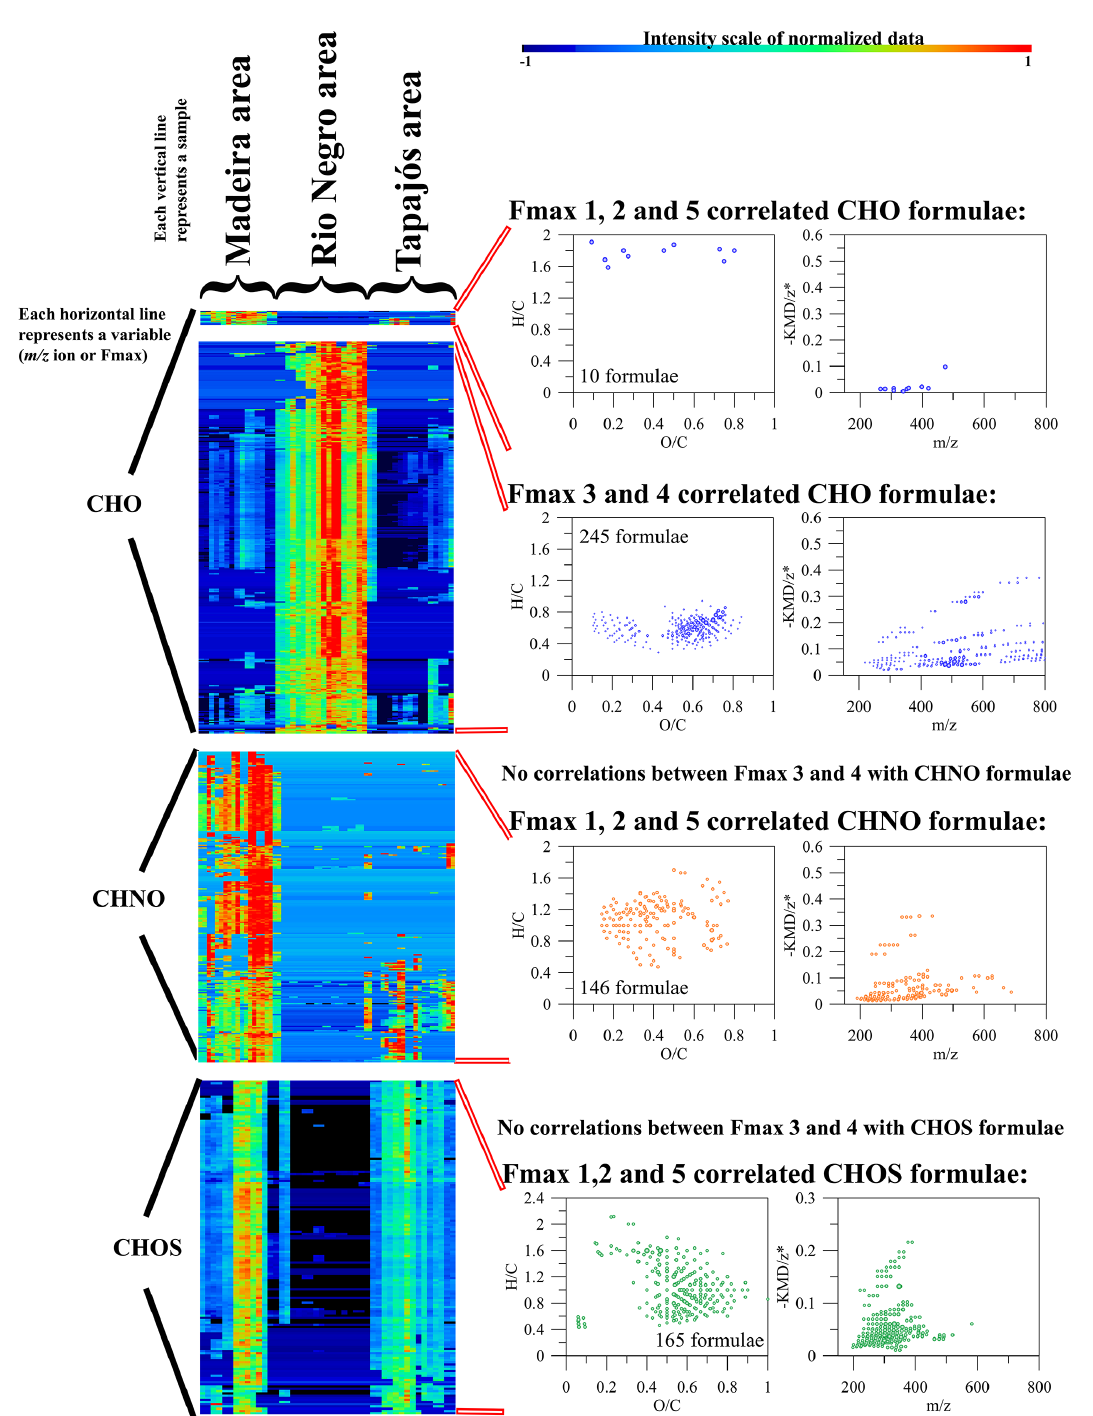
Figure 5. Heat maps of specific Spearman’s rank-correlated hierarchical clusters (distance threshold 0.6) that showed correlations between m/z ions and Fmax values separated into the dissolved organic carbon (CHO) nitrogen (CHNO) and sulfur (CHOS) pool. The van Krevelen diagrams correspond to the molecular signatures that co-varied with specific EEM-PARAFAC Fmax values. The entire heat maps and additional specific m/z ion clusters are given in Fig. S6, including their distribution in the chemical space visualized in van Krevelen